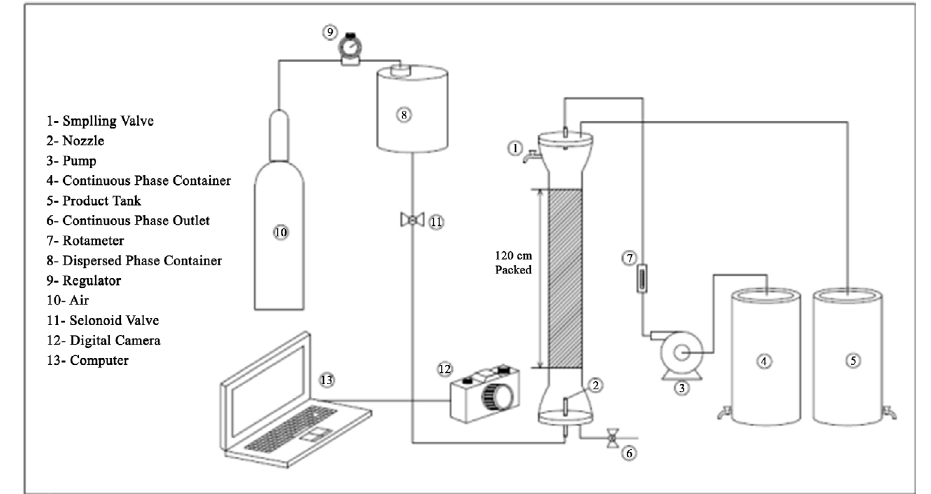
Fig. 1. Schematic diagram of the experimental